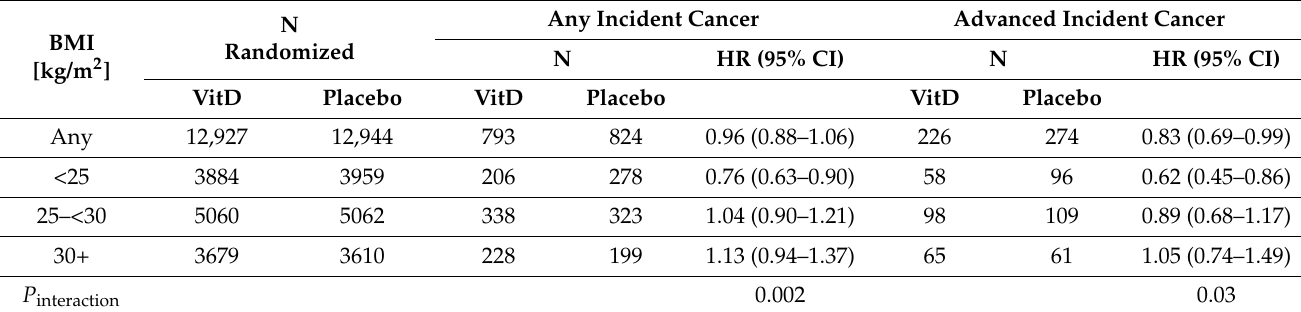
Table 1. Incidence of any cancer and of advanced cancer according to BMI and vitamin D3 supplementation in the VITAL study (data extracted from references [4,5].)